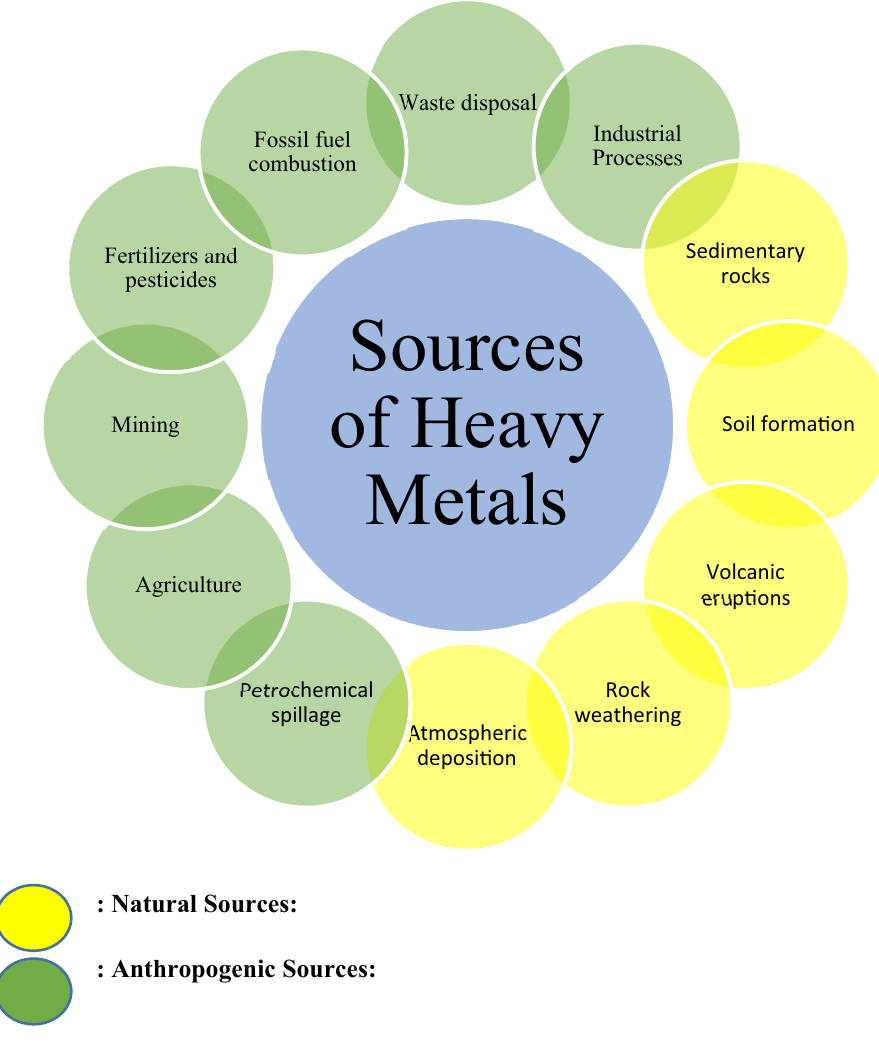
Fig. 1 Sources of metal pol-